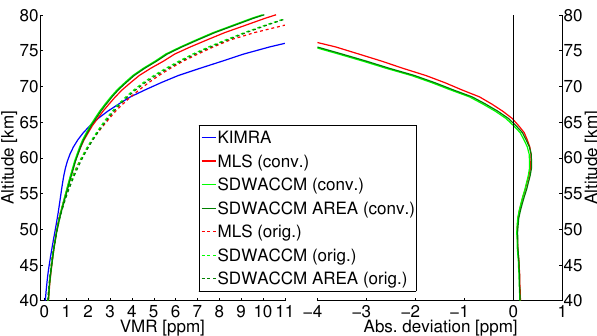
Fig. 2. Comparison of mean profiles for the different datasets. Left: mean profiles. For MLS and SD-WACCM4, the original profiles (“orig.”) as well as those convolved with the KIMRA AVK (“conv.”) are shown. Right: deviation between the convolved SDWACCM and MLS profiles and the KIMRA profile calculated with Eq. (3). Note that the SDWACCM AREA profiles can hardly be seen, as they are almost identical with the SDWACCM